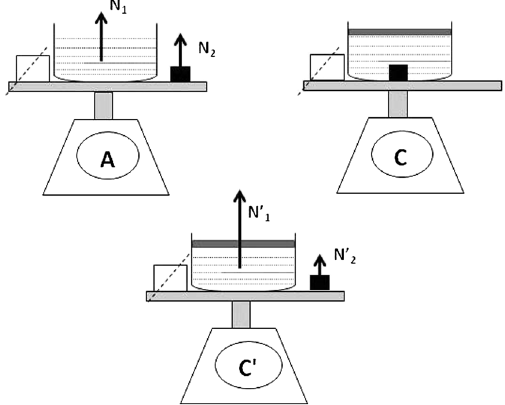
FIG. 5. Analogy proposed by students. The case C ’ , in which the force “ supporting ” the metal cube is smaller than in case